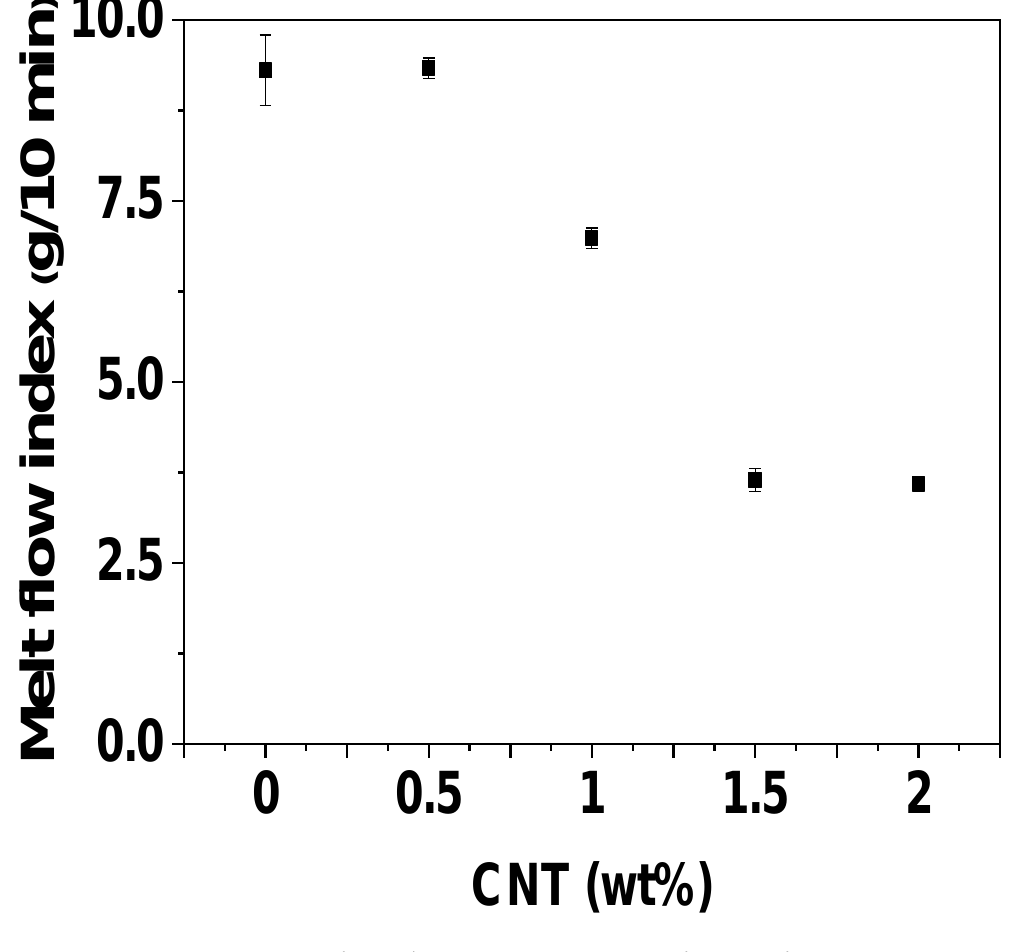
Figure 6. MFI of POM/CNT nanocomposites as a function of CNT concentration.